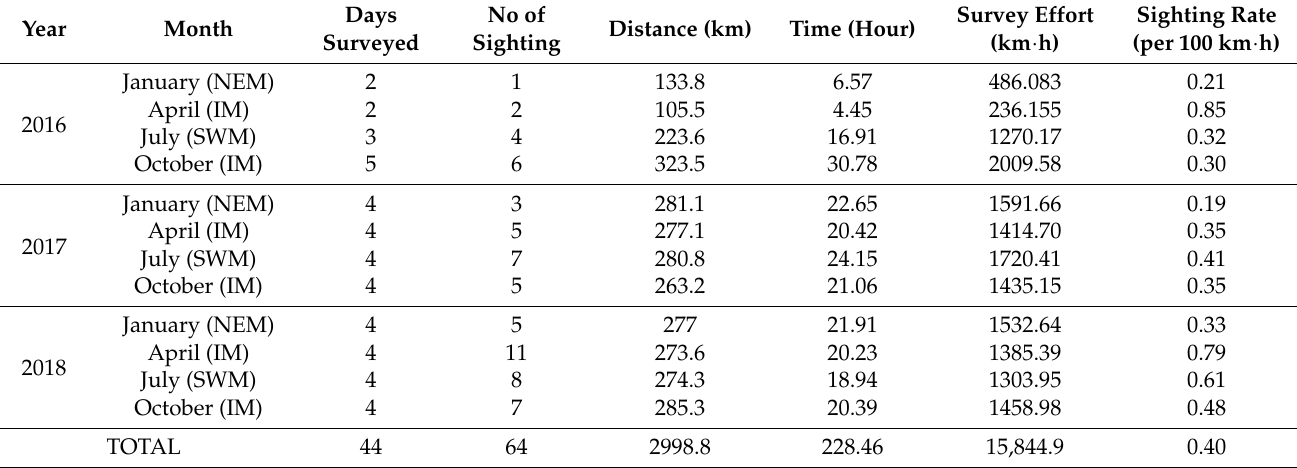
Figure 3. The overall survey tracks in the Bay of Brunei, Brunei Darussalam 2016–2018. Table 1. Cumulative data collection from the boat surveys conducted in the Bay of Brunei, Brunei Darussalam, between 2016 and 2018 according to months (sea states Beaufort